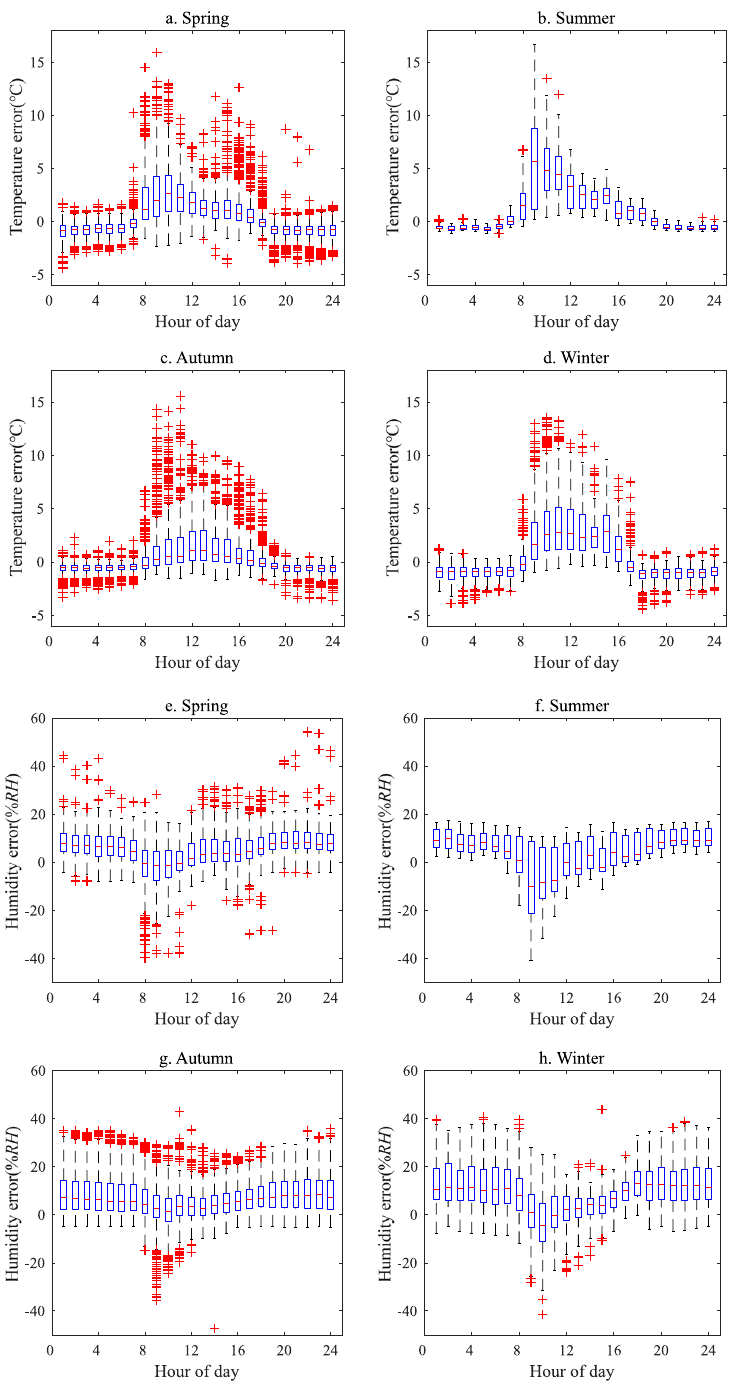
Figure 3. Diurnal variations in the errors in temperature ( a – d ) and humidity ( e – h ) observed by the wireless sensors in the spring, summer, autumn and winter. The symbols in this figure are the same as those in Fig.